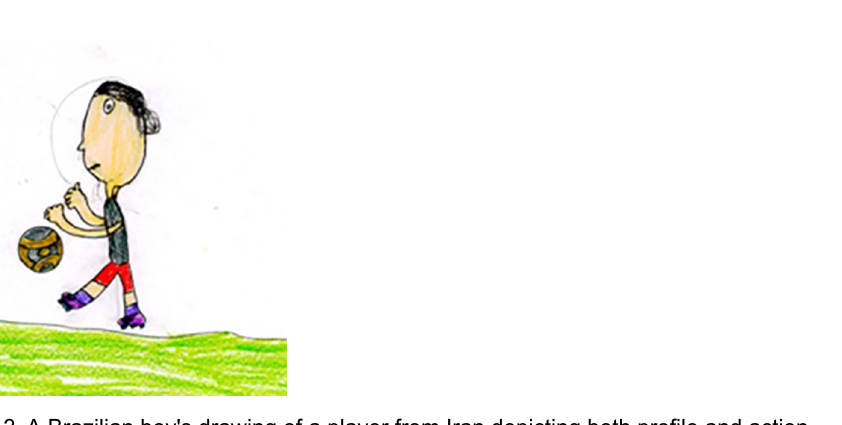
Figure 2. A Brazilian boy's drawing of a player from Iran depicting both profile and action.